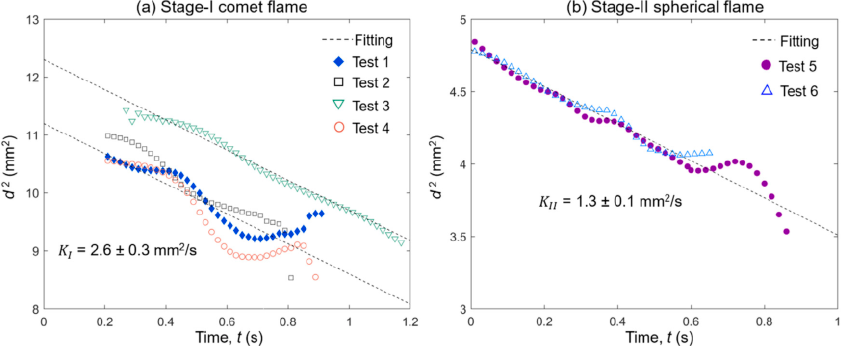
Figure 10. The average burning rate constant for the PE droplets microgravity burning [108].